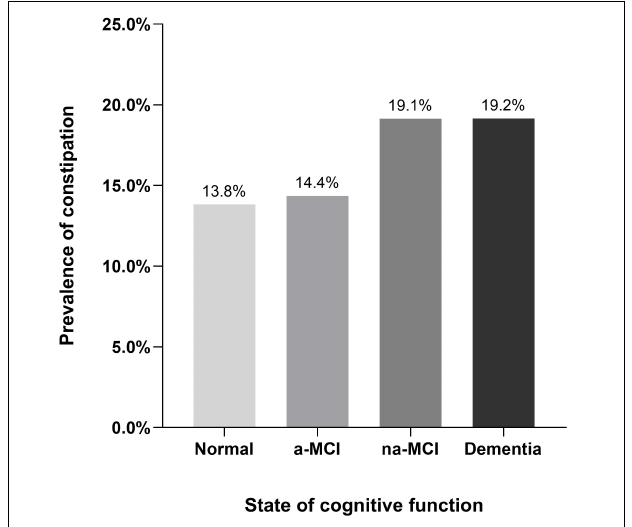
FIGURE 3 | Prevalence of constipation by state of cognitive